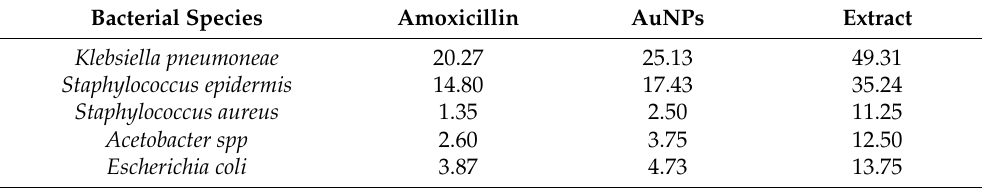
Table 5. Overall, the MIC of plant extract is higher than AuNPs (Table 5). Table 5. Minimum inhibitory concentration ( µ g/mL) of extract and its mediated AuNPs. Bacterial Species